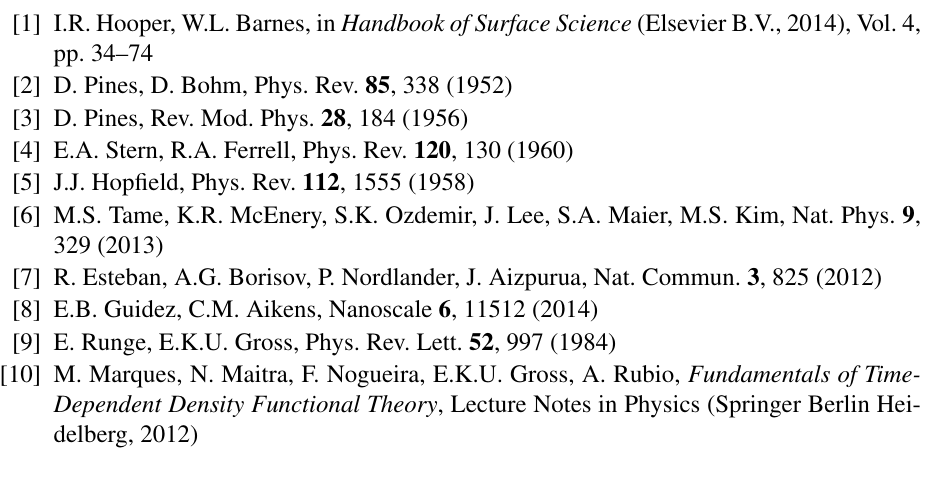
Figure 3. DOS for a SWCNT when electrons are removed from it.